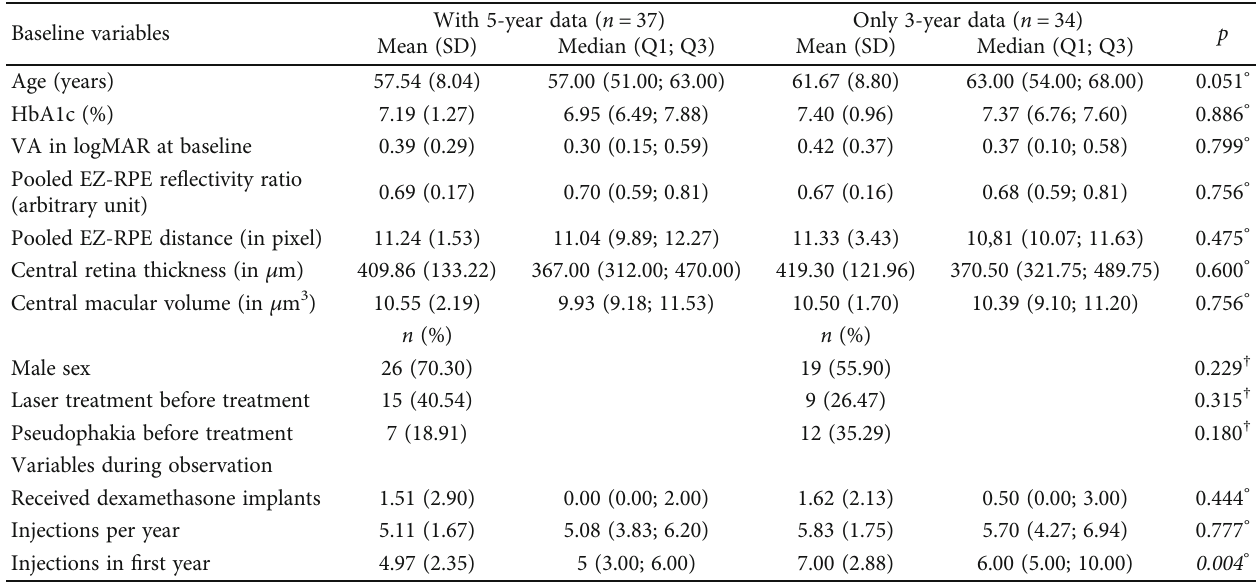
Table 1: Demographics and characteristics for patients with 5-year data ( n = 37 ) compared to patients with only 3 years of follow-up ( n = 34 ). Baseline variables